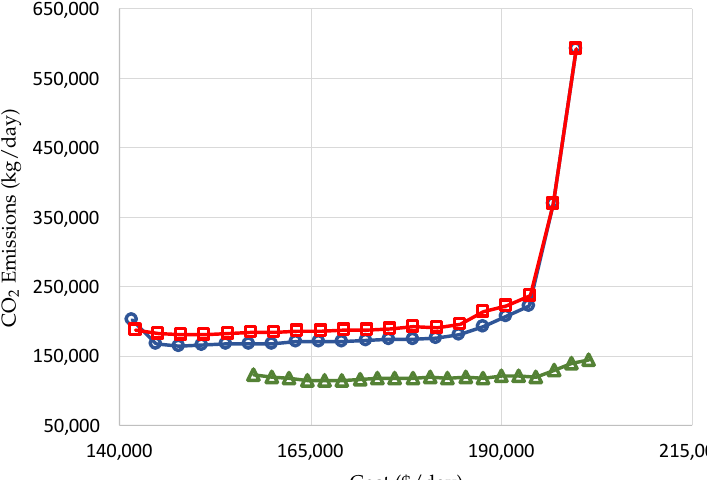
Figure 9. Cost vs. CO 2 Pareto set for Scenario 1 (– ◦ – blue), Scenario 2 (– (cid:3) – red), and Scenario 3 (– (cid:52) –